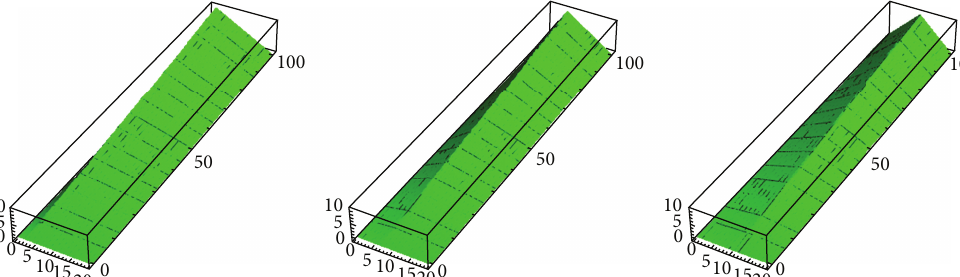
Figure 8: Coons patch for 𝑥 𝑖 = 2, 6, 10 .